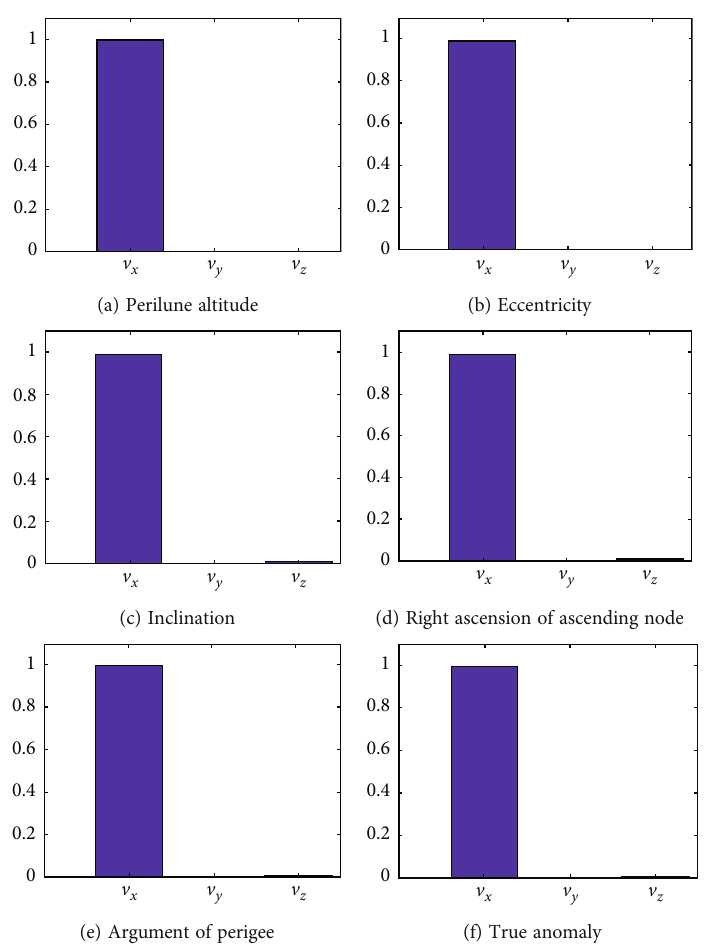
Figure 8: Histogram of the global sensitivity index of the velocity parameters to the orbital elements at the